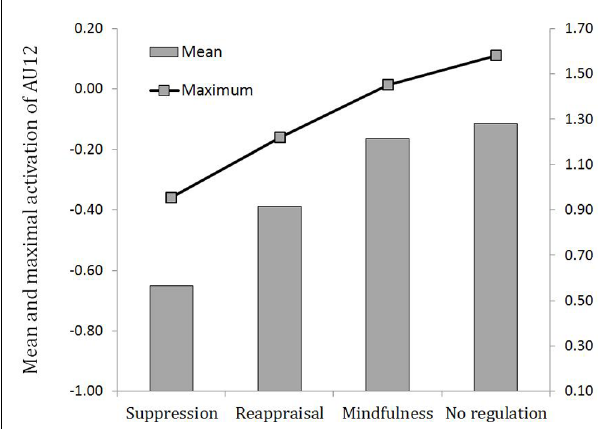
FIGURE 2 |Average and maximal activation ofAU12 (lip corner puller) depending on the regulation strategy condition. Left ordinate axis refers to average activation and right ordinate axis refers to maximum activation.